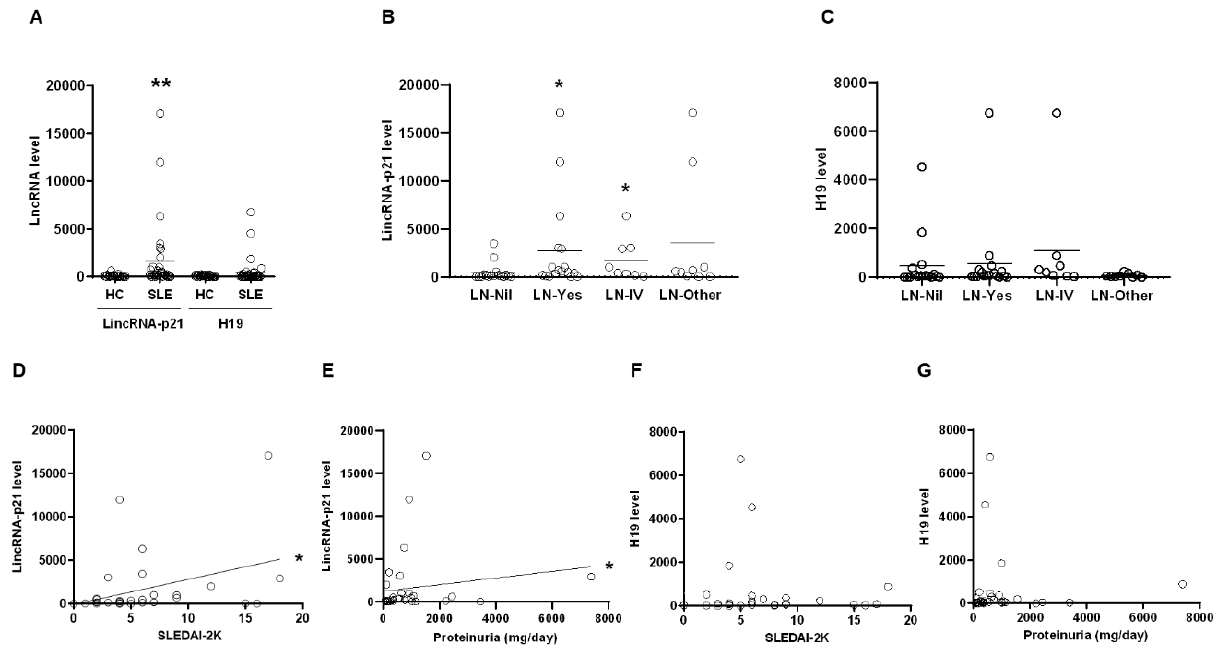
Figure 1. Up-regulated expression of lincRNA-p21 in PBMNCs from systemic lupus erythematosus (SLE) and lupus nephritis (LN) patients. ( A ) LincRNA-p21 and H19 levels in healthy controls (HCs) and SLE patients. ( B ) LincRNA-p21 levels in SLE patients without renal involvement and LN patients, including IV histopathology and others. ( C ) H19 levels in SLE without renal involvement and LN patients including IV histopathology and others. ( D , E ) A significant positive correlation between lincRNA-p21 levels and SLEDAI-2K scores or daily proteinuria amounts in SLE patients. ( F , G ) No correlation between H19 levels and SLEDAI-2K scores or daily proteinuria amounts in SLE patients. Horizontal lines in ( A – D ) are mean values from HCs and patients. n = 30 for HCs, n = 34 for SLE patients, n = 17 for LN patients, n = 17 for SLE without renal involvement, n = 8 for LN patients with IV histopathology, and n = 9 for other LN patients. * p < 0.05, ** p < 0.01 .